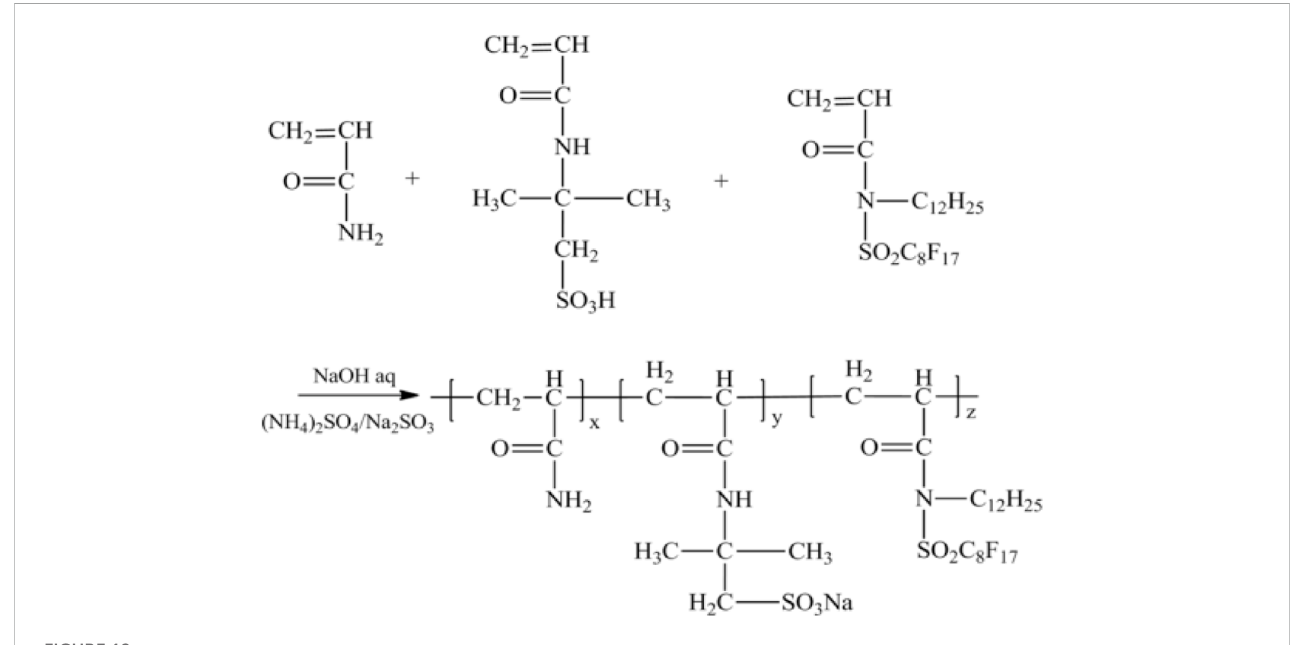
FIGURE 12 Synthesis route of FPAM (Chen et al.,